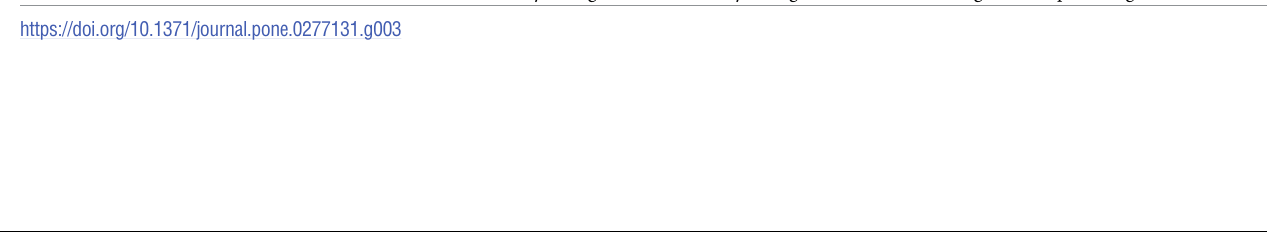
PLOS ONE | https://doi.org/10.1371/journal.pone.0277131 December7,